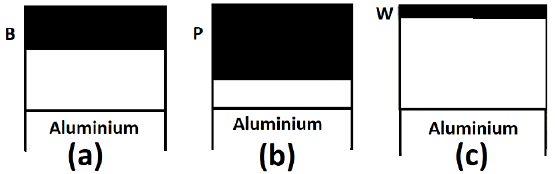
Figure 4. Schematic diagrams of sections of barrier films formed on aluminum in: ( a ) borate; ( b ) phosphate; and ( c ) tungstate electrolytes, adapted and reproduced with permission of Elsevier from Ref [69].